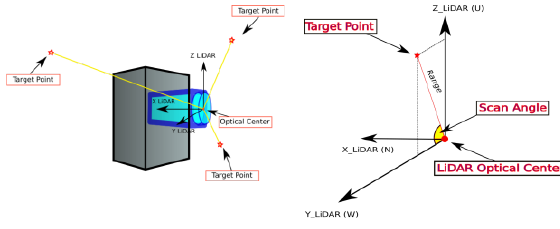
Figure 4 – Local LiDAR frame with spherical